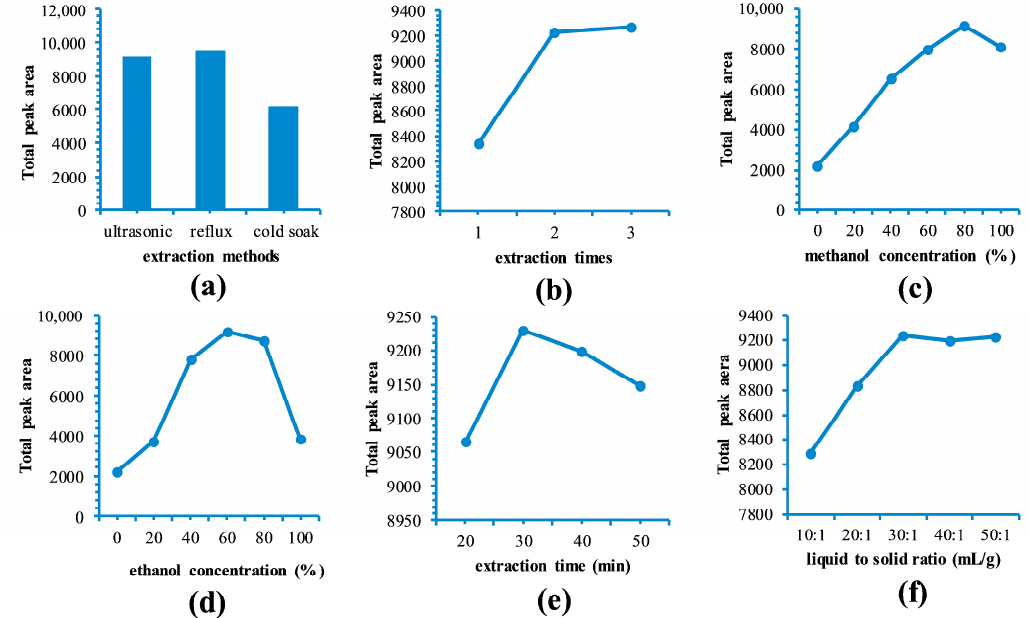
Figure 1. Results of single factor experiments (total peak area for 11 compounds): ( a ) extraction methods; ( b ) extraction times; ( c ) methanol concentration (%); ( d ) ethanol concentration (%); ( e ) extraction time (min); ( f ) liquid to solid ratio (mL/g).